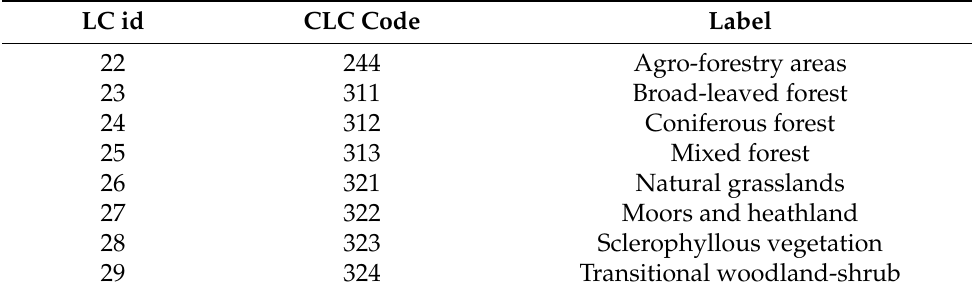
Table 1. Translation table for Corine land cover translation to Land Cover id.